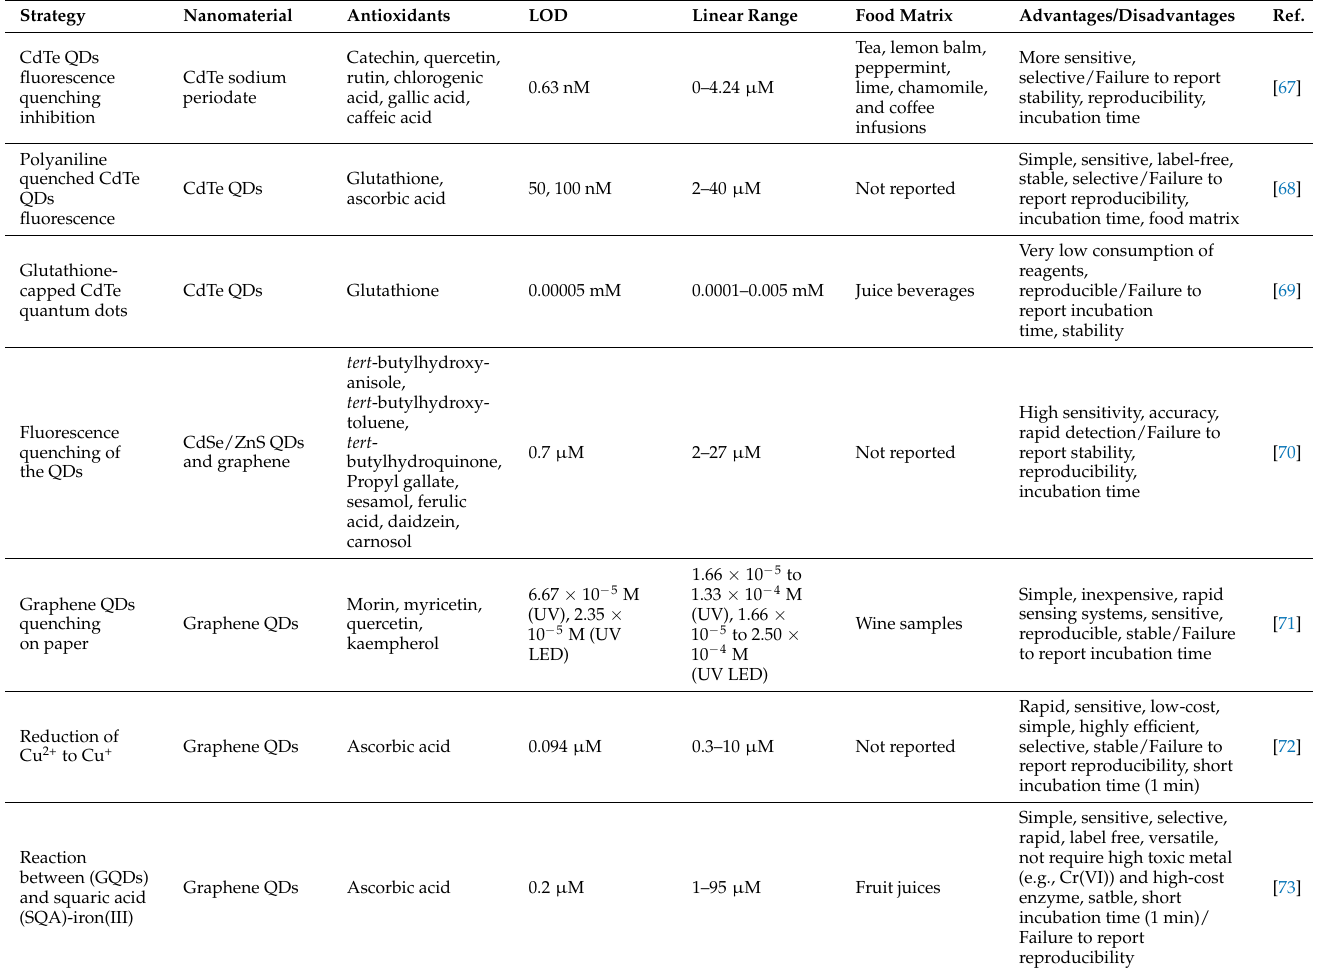
Table 2. Representative examples of recent developed fluorescence assays for the determination of antioxidants in food samples. Strategy Linear Range Food